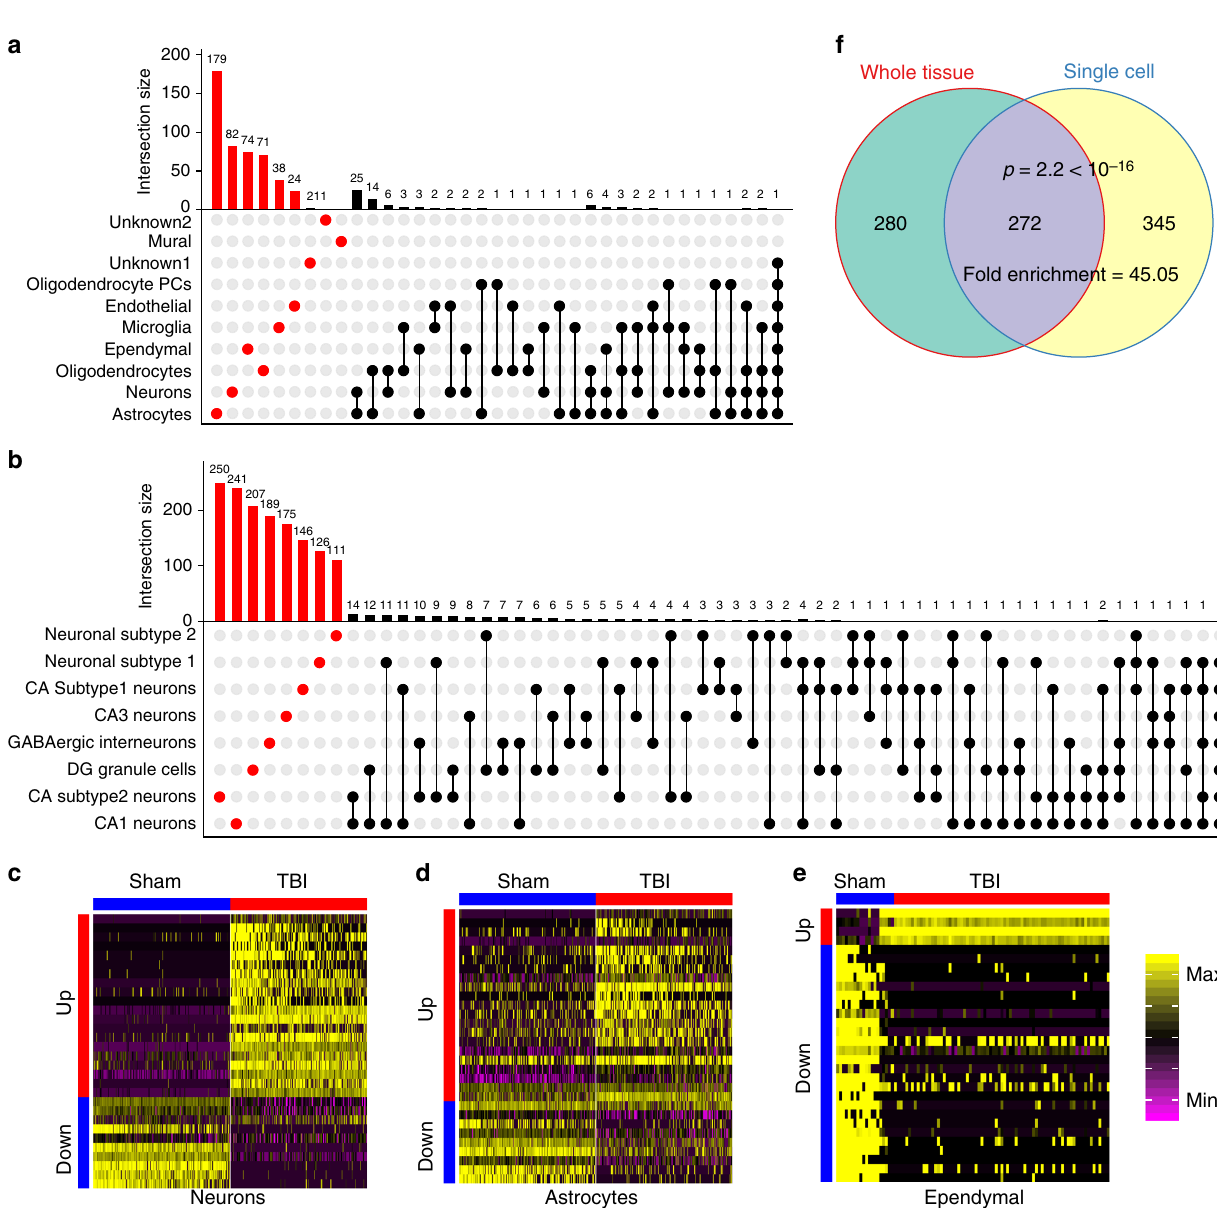
Fig. 5 Differentially expressed genes (DEGs) induced by TBI in hippocampal cell types. a , b DEGs unique to a cell type are indicated in red and those shared between ≥ 2 cell types are indicated by black dots. The histogram above each plot indicates the DEG counts for each category. a The majority of the DEGs are cell-type speci fi c. b The majority of the DEGs in neuron subtypes are subtype-speci fi c. c – e Heatmaps of DEGs in select cell types demonstrate clear differential expression patterns between Sham and TBI cells. f Many cell-type speci fi c DEGs cannot be captured in the bulk tissue analysis, supporting the uniqueness of using single cell genomic analysis. DEG overlap p -value was calculated using Fisher ’ s exact